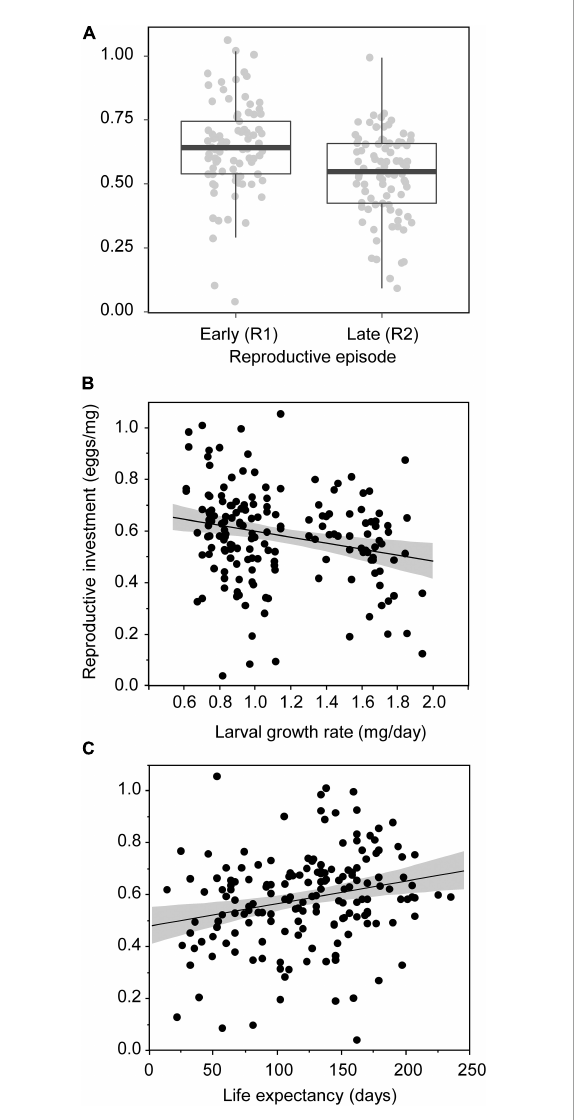
FIGURE3 Reproductive investment (number of eggs per mg of body mass) of females Tenebrio molitor , according to reproductive episode (early reproductive episode, R1: females 10–20 days old post-eclosion; late reproductive episode, R2: females 40–50 days old post-eclosion) (A) ; as a function of the female’s growth rate (B) and as a function of life expectancy at reproductive episode (C) . Each dot represents the measure of a single female during one reproductive episode. Lines are linear regressions with 95% confidence intervals.